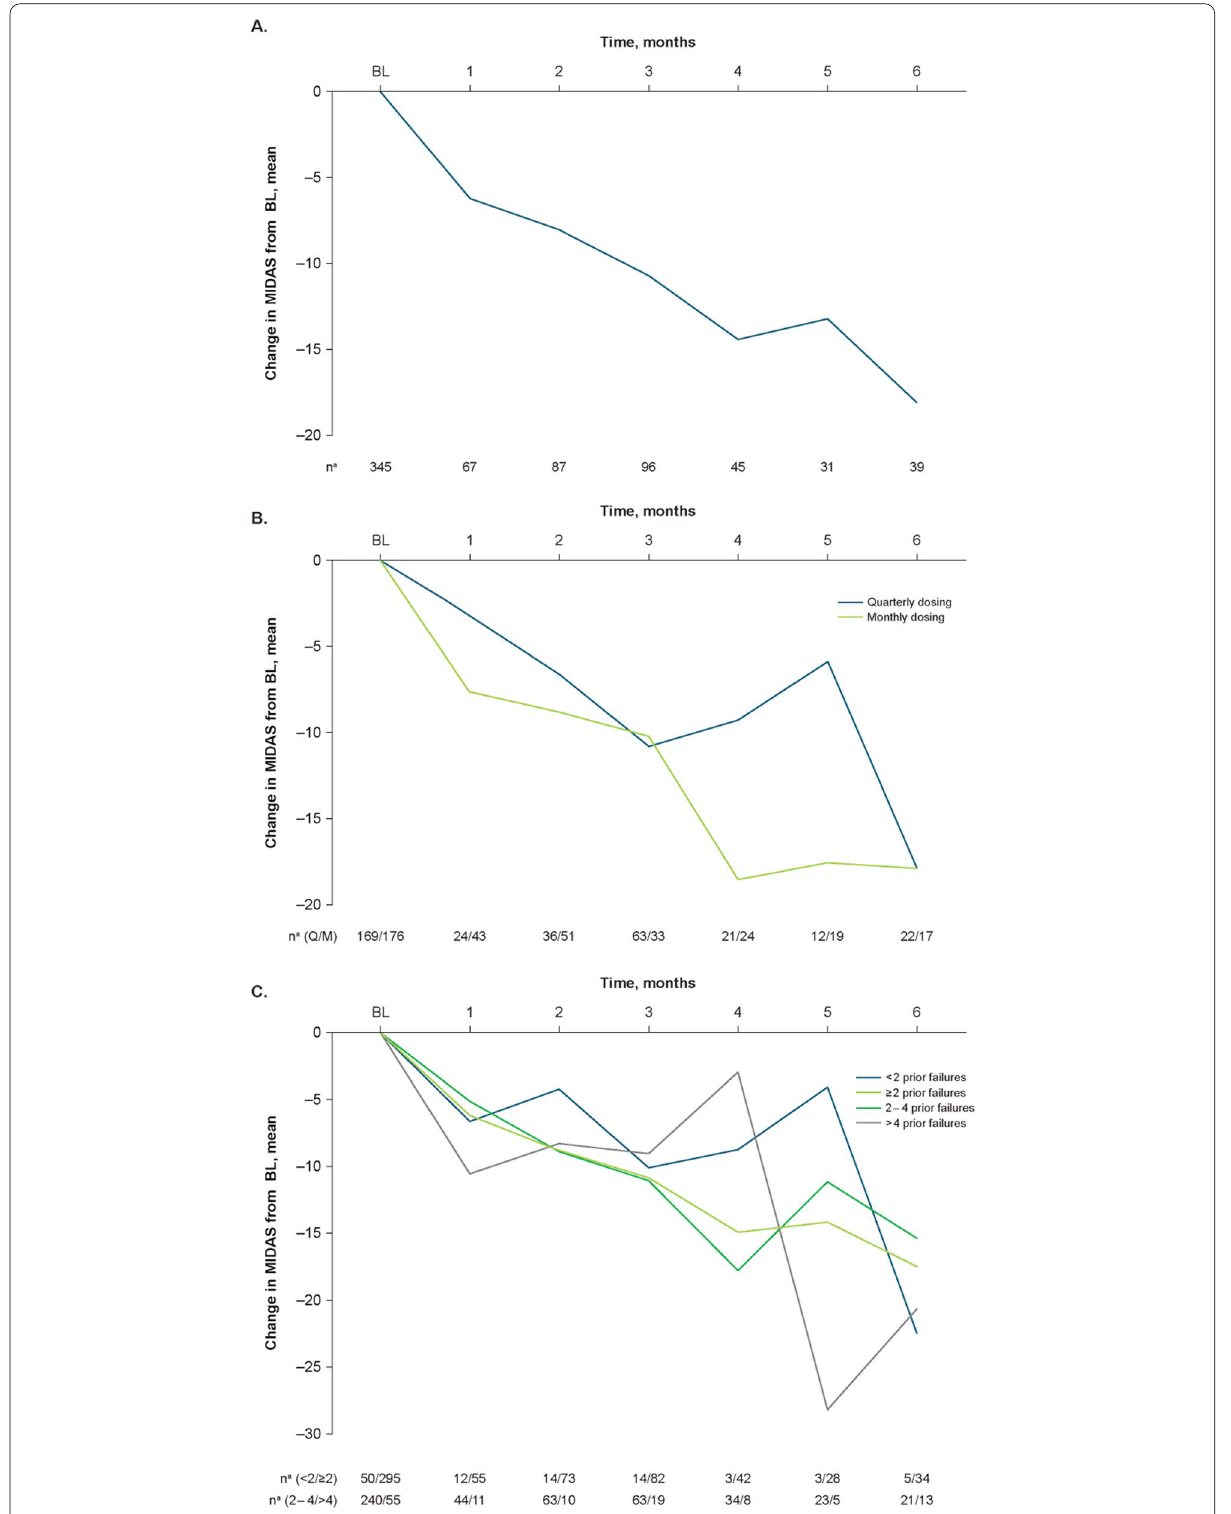
Fig. 6 Effectiveness outcomes by change from baseline in MIDAS score: A ) total population; B ) dosing schedule subgroups; C ) prior treatment failures subgroups. BL, baseline; MIDAS, Migraine Disability Assessment; Q, quarterly; M, monthly. a Number of patients with available assessment at each time